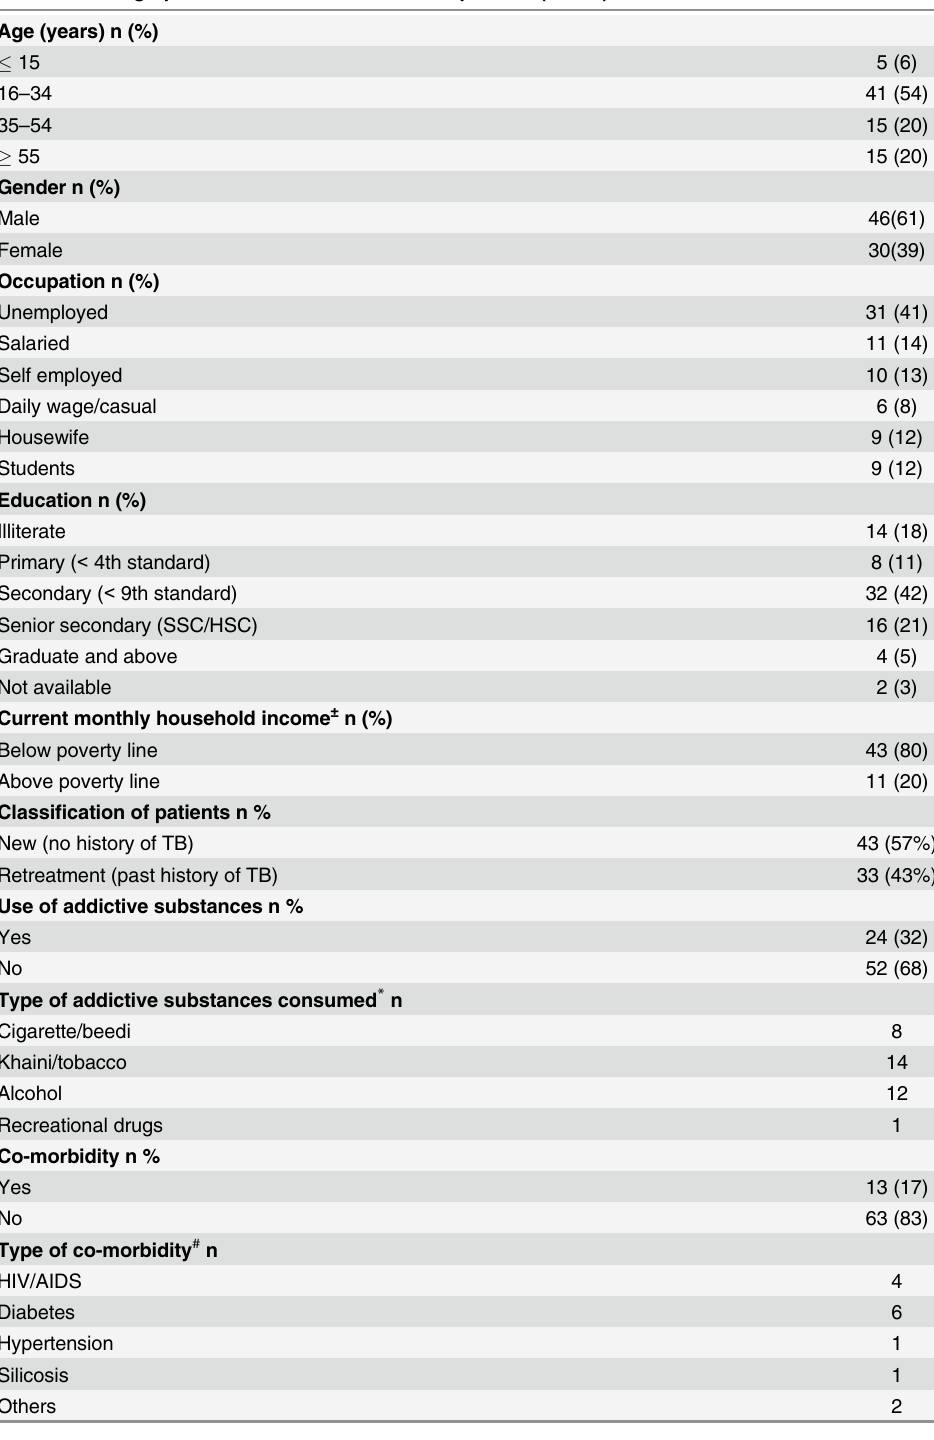
Table 1. Demographics and characteristics of the patients (N =